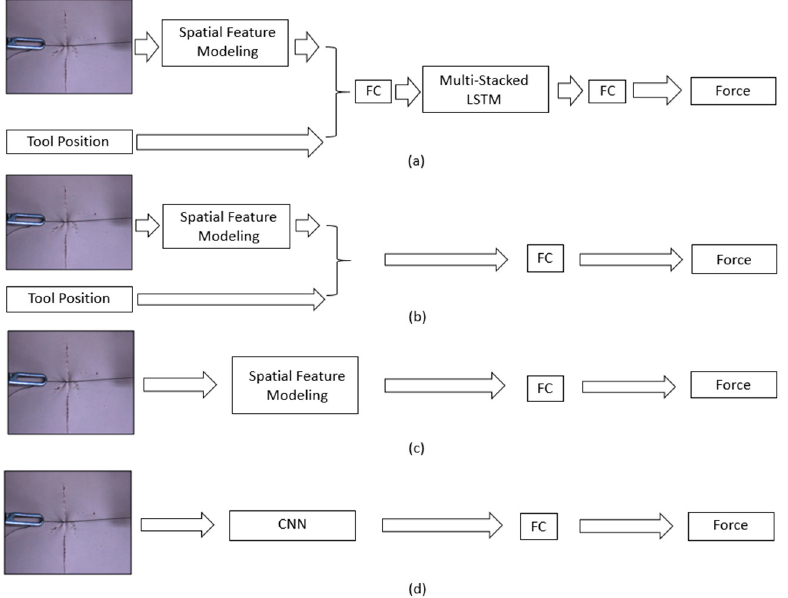
Figure 7. Network structure diagram: ( a ) proposed network, ( b ) comparison network 1 with inception-based spatial feature modeling and tool position, ( c ) comparison network 2 with Incep-